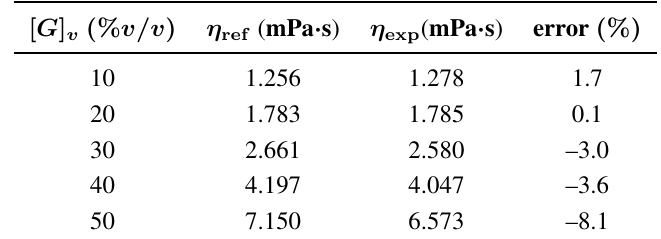
Table 3. Comparison between reference viscosities η the PSDs of the measured thermal noise η of 10 % to 50 %